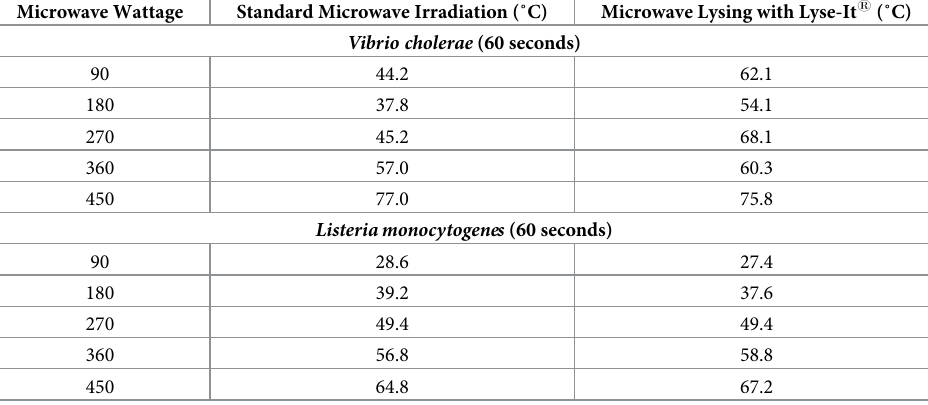
Table 1. Microwave irradiation